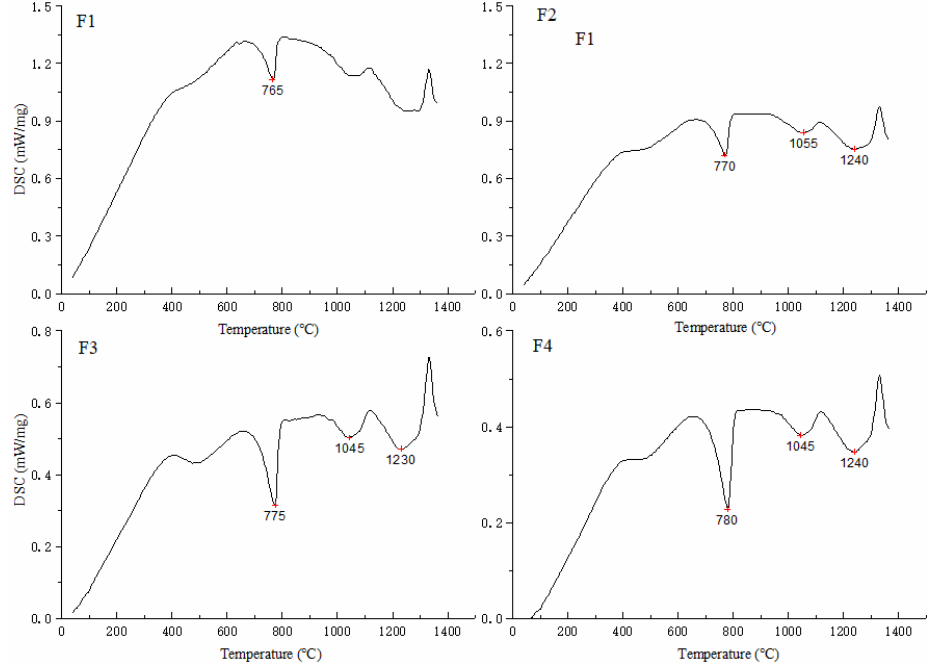
Figure 1. DSC curves of raw materials.